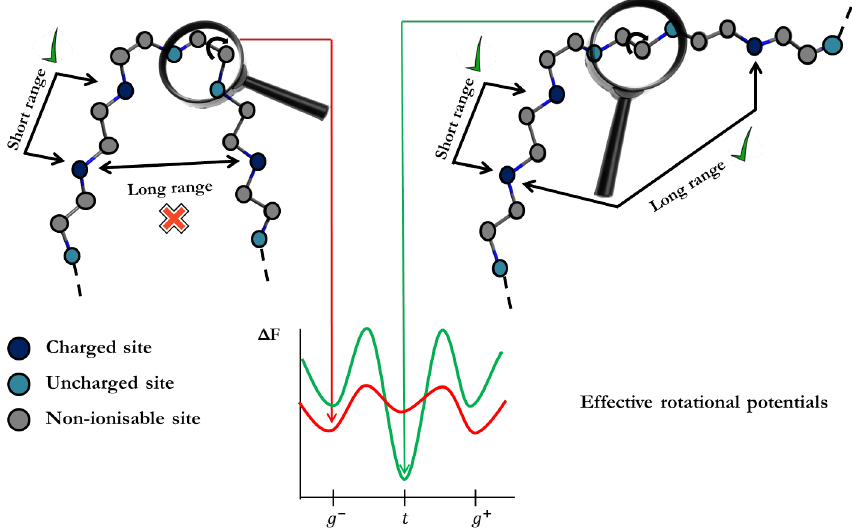
Figure 3. Outline of the Local Effective Interaction Parameters (LEIP) method. LEIP accounts for the Short-Range (SR) interactions exactly, but LR interactions are replaced by effective SR free